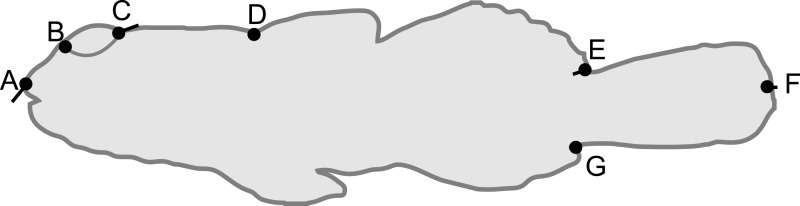
Schematic of Bathygobius cocosensis in side (lateral) view, illustrating the position of the seven landmarks (black filled circles) recorded to describe body shape.Landmarks were: tip of the snout (A), the anterior (B) and posterior (C) edges of the eye, the origin of the dorsal fin (D), dorsal caudal fin origin (E), the ventral origin of the caudal fin (F) and posterior point of caudal fin (G). Total length was measured as the distance between (A) and (F). Black vectors from landmarks illustrate the change in landmark position from low PC6 scores (short snout and small eyes) toward high PC6 scores (long snout and big eyes). Most of the change along this axis of phenotypic variation involved anterior-dorsal shift of landmark (A), and posterior shift in the position of landmark (C); some landmarks did not contribute variation to this component of shape variation. Vectors = 0.04 scale in MorphoJ.